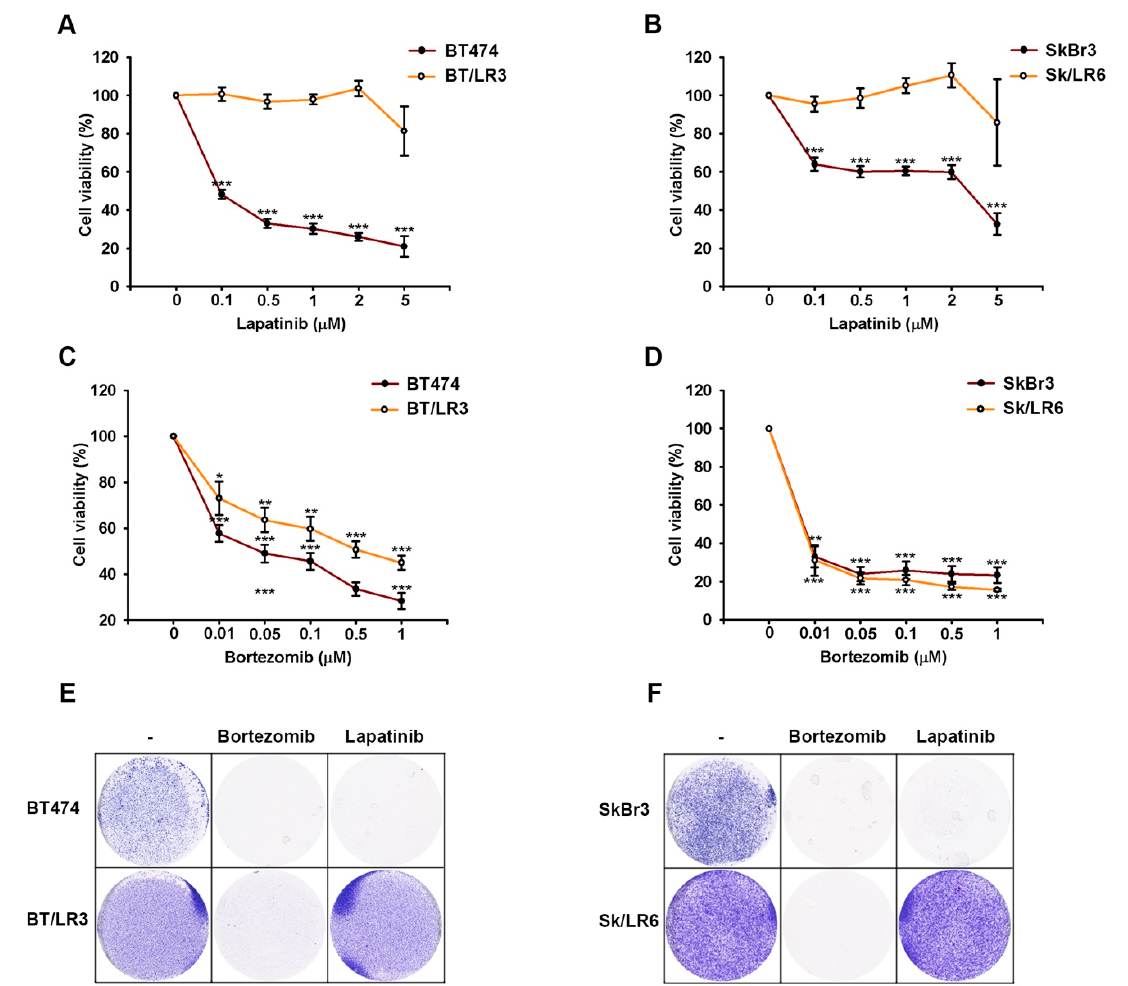
Figure 2. Growth inhibition of lapatinib-resistant breast cancer cells by bortezomib. BT474 and SkBr3 cells and their lapatinib-resistant clones were treated with indicated concentrations of lapatinib and bortezomib for three days and seven days, and were then subjected to cell viability by MTT assay ( A – D ) and clonogenic assay ( E , F ), respectively. The concentrations of lapatinib and bortezomib used in the clonogenic assay were 1 µ M and 50 nM, respectively. Results are showed as mean ± SD of three independent experiments. p values < 0.05, < 0.01, and < 0.001 are indicated as *, **, and ***, respectively.